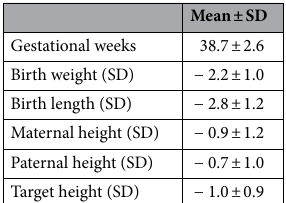
Table 1. Data at birth and parental height in patients born small for gestational age without postnatal catch-up growth (n = 50). SD standard deviation.